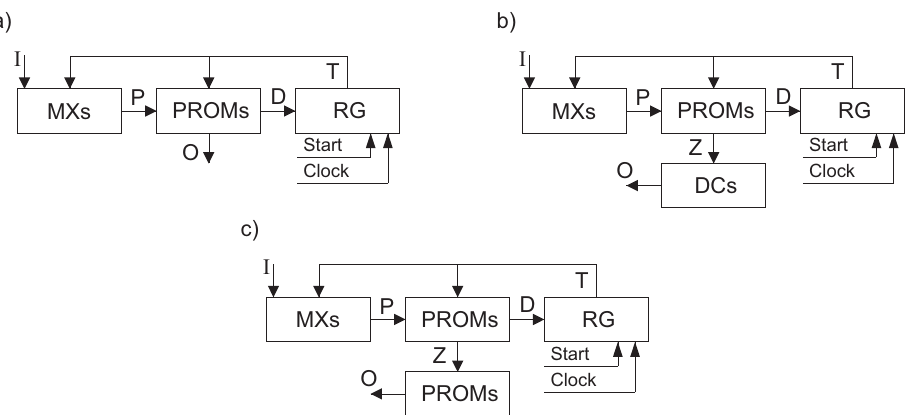
Figure 14. Organization of MP ( a ), MPD ( b ), and MPY ( c ) programmable read-only memory (PROM)-based